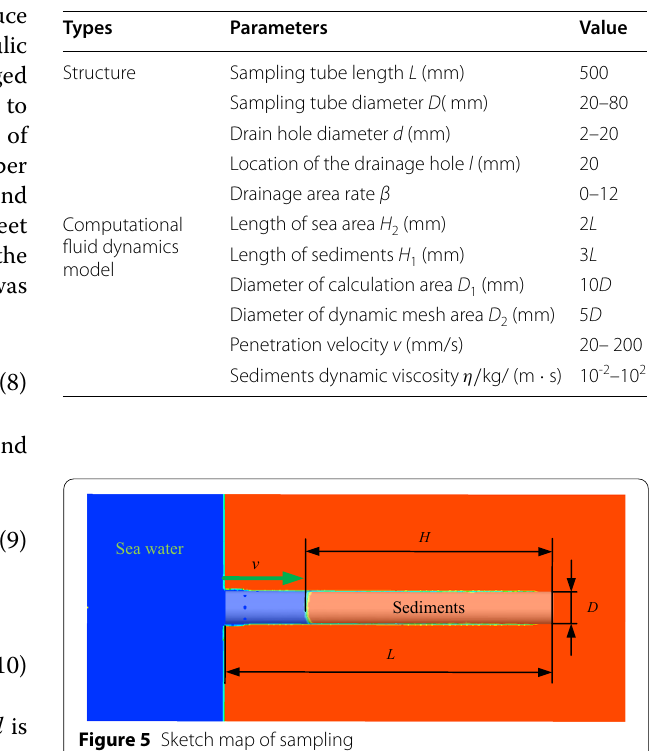
Table 1 Parameters of computational fluid dynamics model